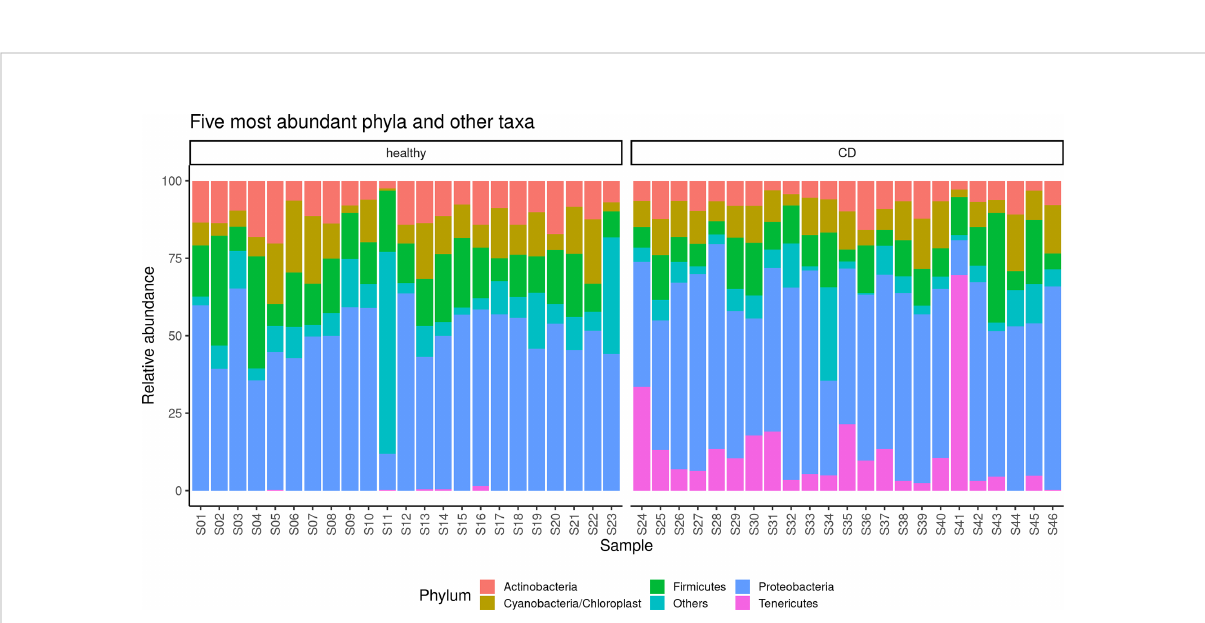
FIGURE 2 Taxonomic composition of the paraf fi n – embedded ileal samples in ileal and CD tissues. The stacked bar plot shows the relative abundance of the fi ve more abundant bacterial phyla in each sample, the “ Others ” group contains phyla with ranks below fi